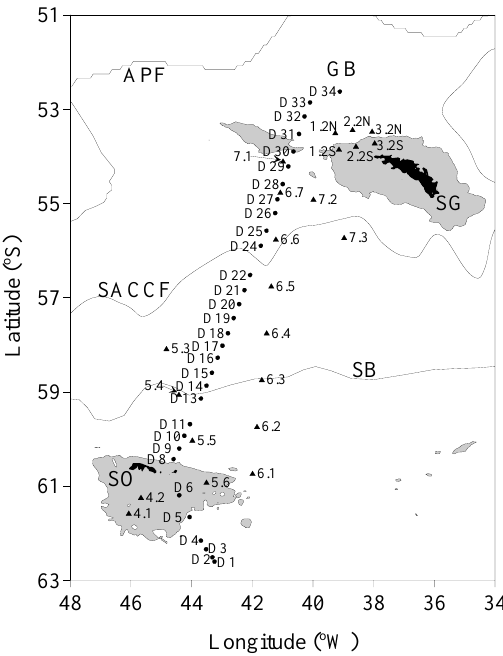
Fig. 1. Station locations of the 2008 (circles) and 2003 (triangles) Scotia Sea surveys. Grey shading indicates the 2000m isobaths. Mean frontal positions are indicated by; APF – Antarctic Polar Front, SACCF – Southern Antarctic Circumpolar Current Front and SB – Southern Boundary. GB – Georgia Basin, SG – South Geor- gia, SO – South Orkney